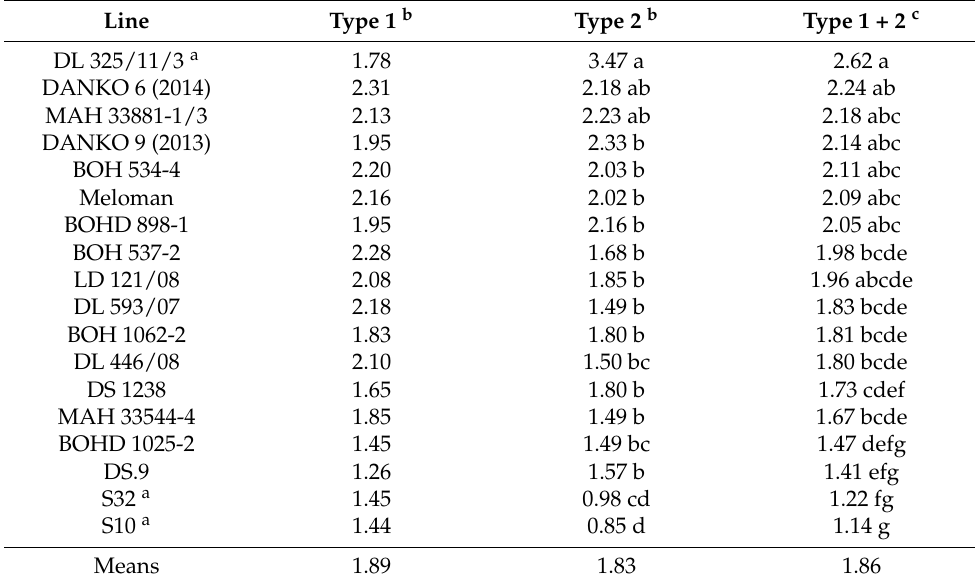
Table 9. Type 1 and type 2 resistance to Fusarium head blight of 15 winter triticale and three winter wheat